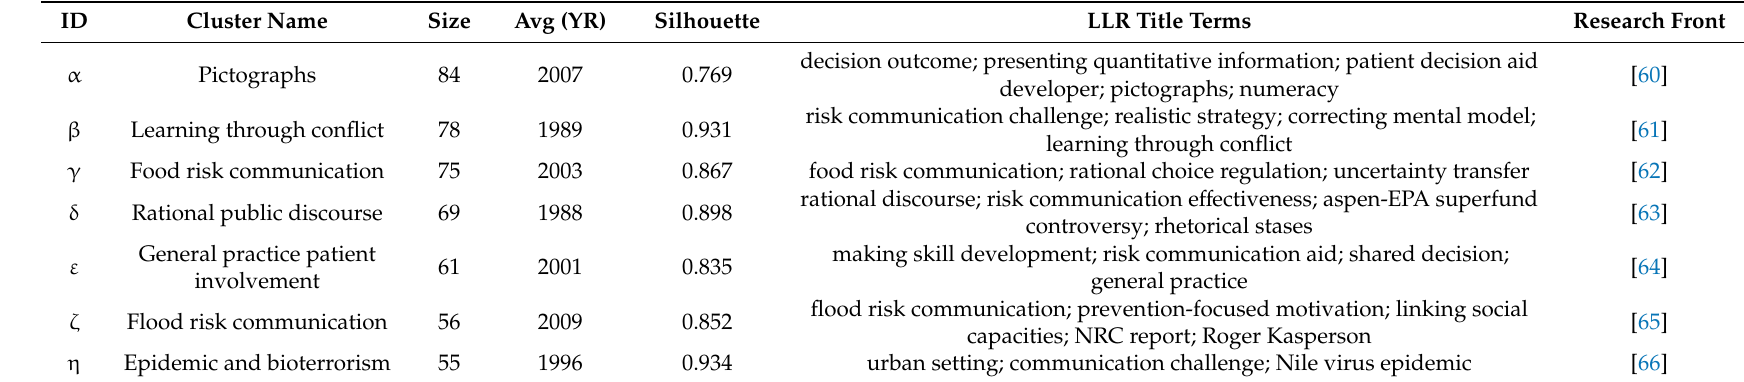
Table 8. Research clusters in risk communication research in connected largest network, clusters including a minimum of five